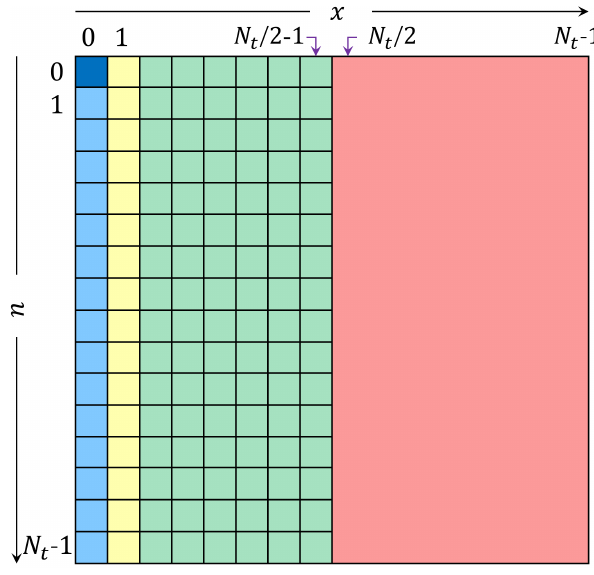
Figure A2. Parts of the